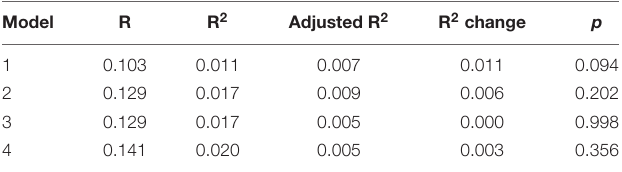
TABLE 6 | Hierarchical regression analysis results controlling for developmental